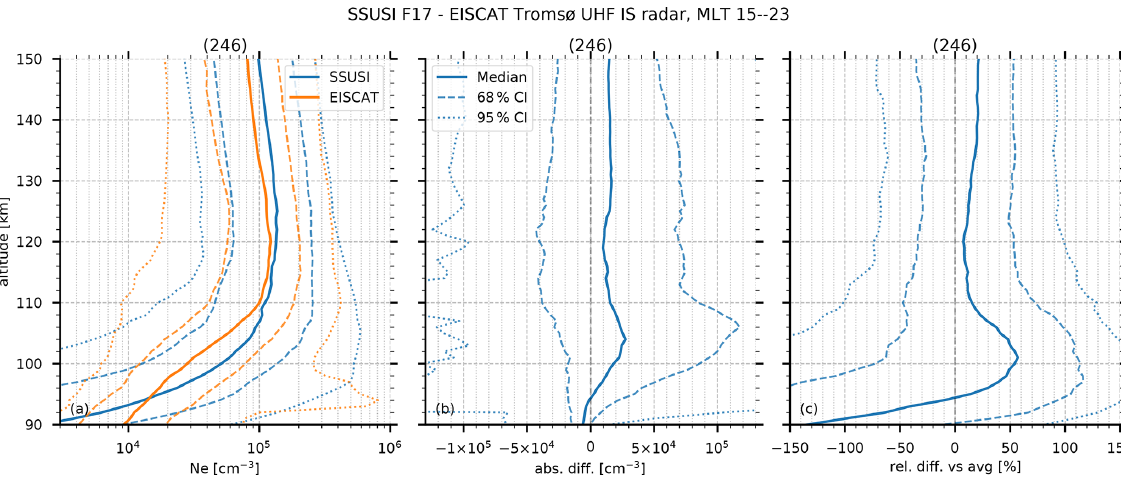
Figure 4. Profile comparison as in Fig. 2 for SSUSI on DMSP/F17 and the EISCAT Tromsø UHF radar for late MLT (15:00–23:00MLT). The SSUSI profiles have been calculated assuming a Gaussian electron spectrum with E 0 = E SSUSI and 43.73eV per ion pair; details can be found in the